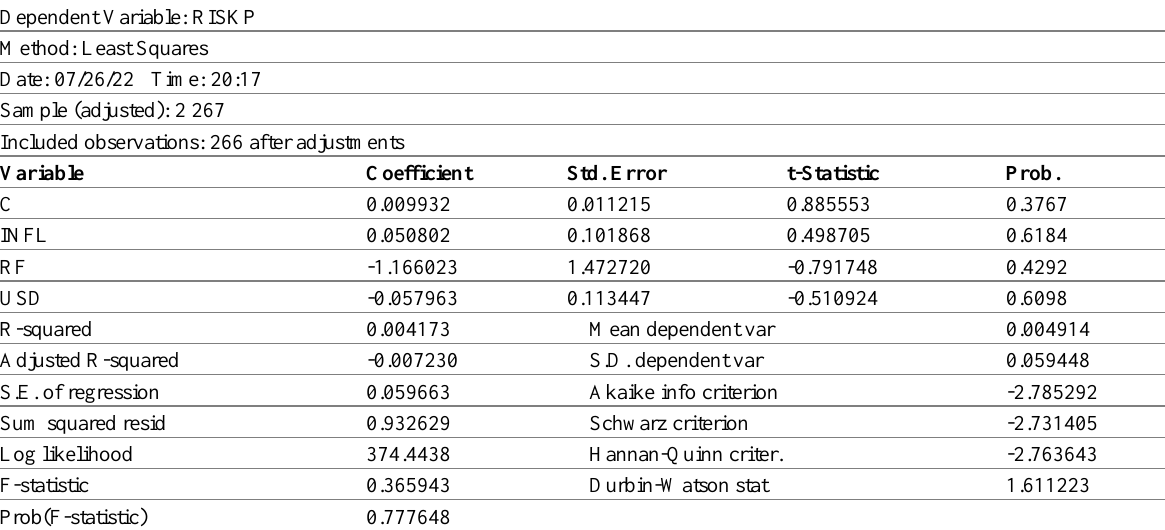
Table 4: Test Results for the Effect of Interest Rates, Inflation, and Exchange Rates on Risk Premium (monthly